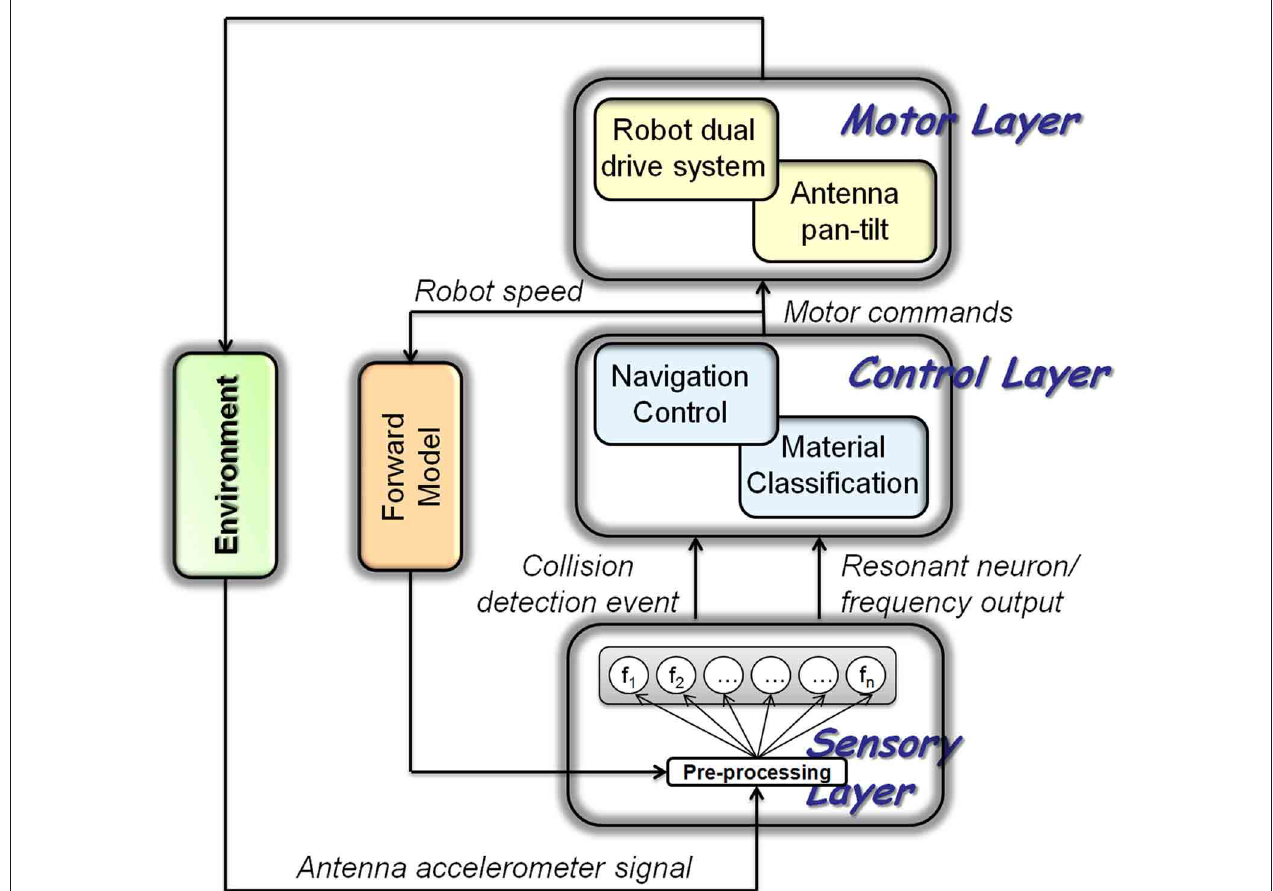
actuate both robot wheels and the pan-tilt unit of the antenna. Details of the Motor Layer and the Navigation Control unit of the Control Layer are beyond the scope of this paper. The presence of a forward model for self-motion compensation has been considered by using a sensory gating strategy. The commands for speed were used to modify the pre-processing of the antennal acceleration sensor in oder to compensate for self-induced sensor